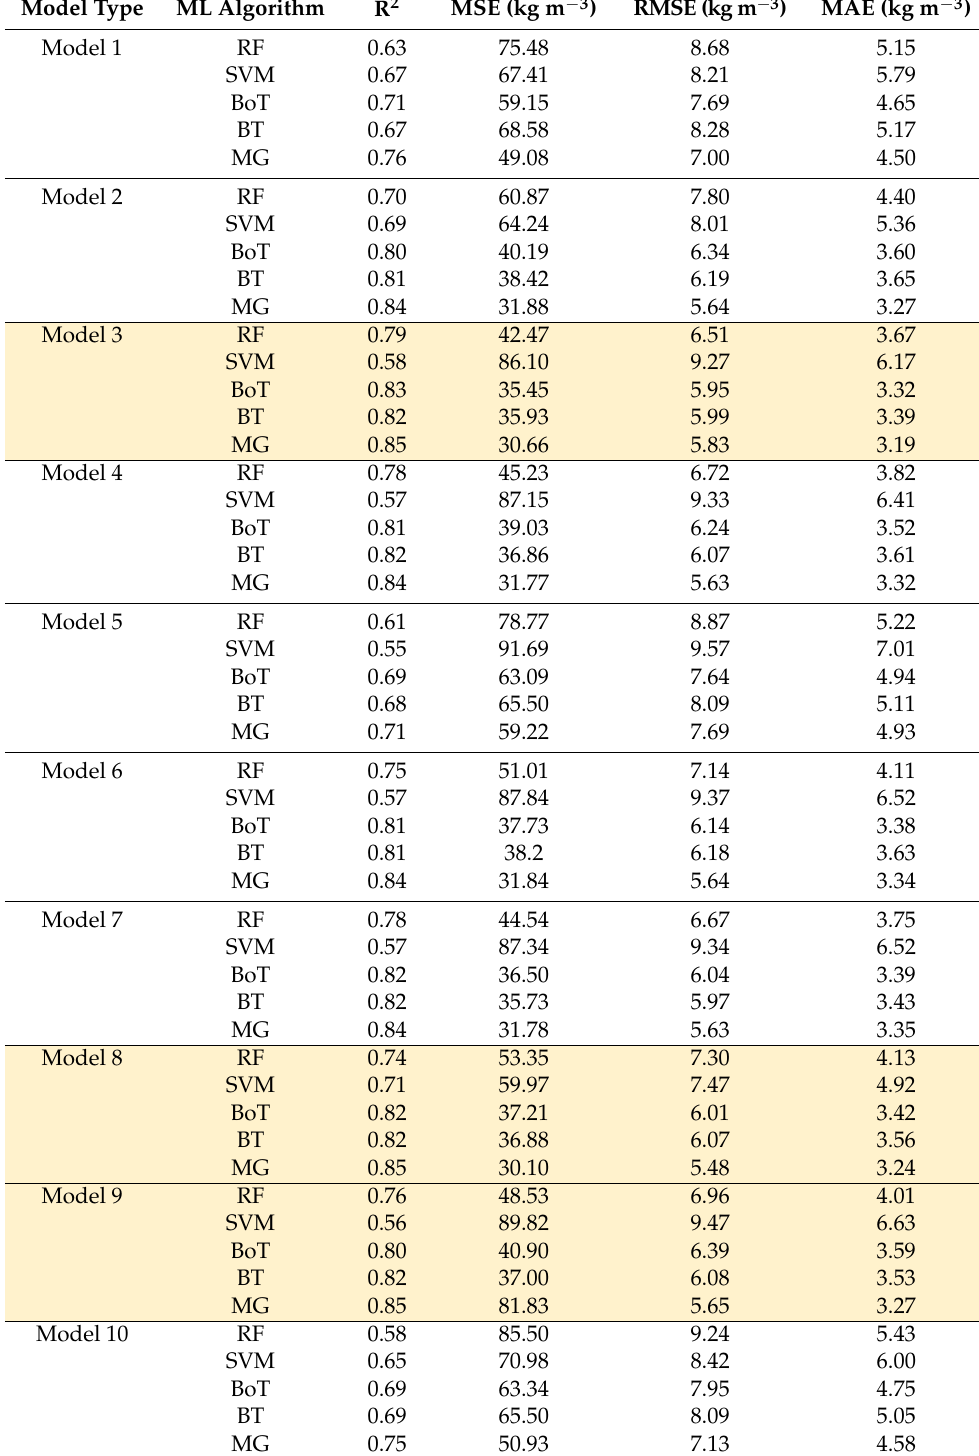
Highlighted models indicate best performance of machine learning algorithm considering R 2 , MSE, RMSE, and